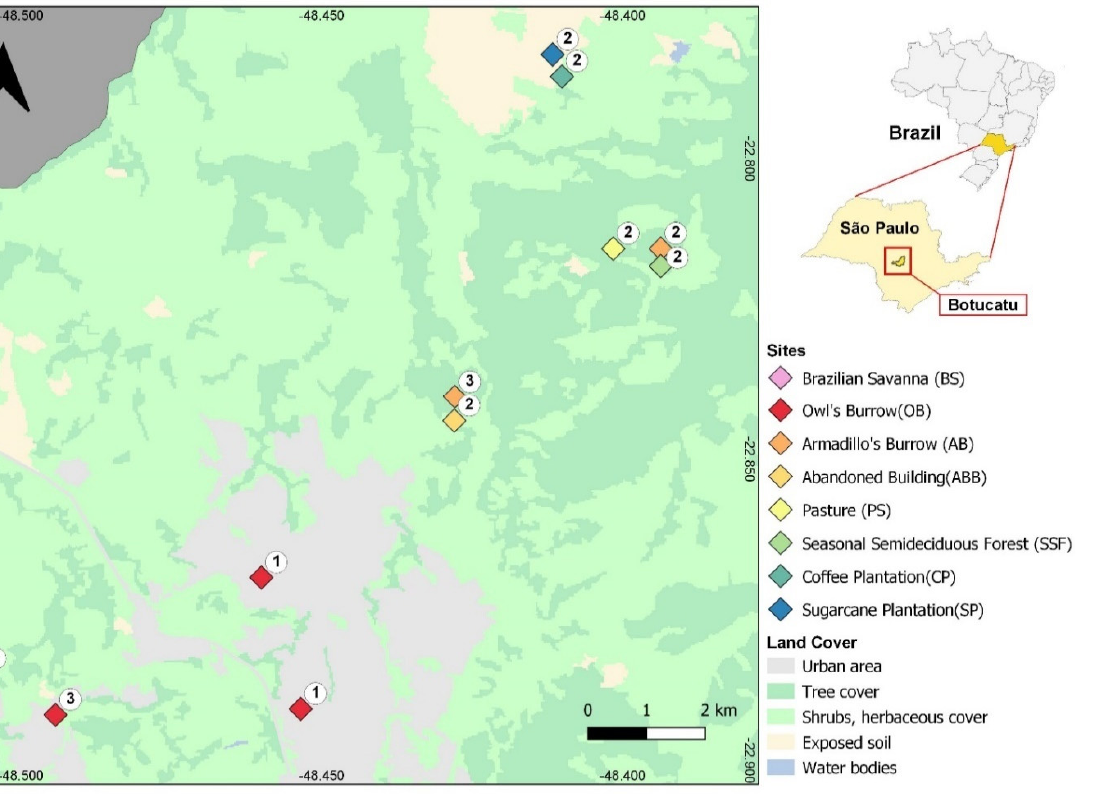
Figure 1. Map of study area and sample points, Botucatu, S ã o Paulo, Brazil. The map was generated with the software QGIS version 3.6 Noosa (QGIS Development Team, 2019. Geographic Information System of QGIS. Geospatial Foundation Open Source Project). The number of collected samples for one season are notated at each collection point (22